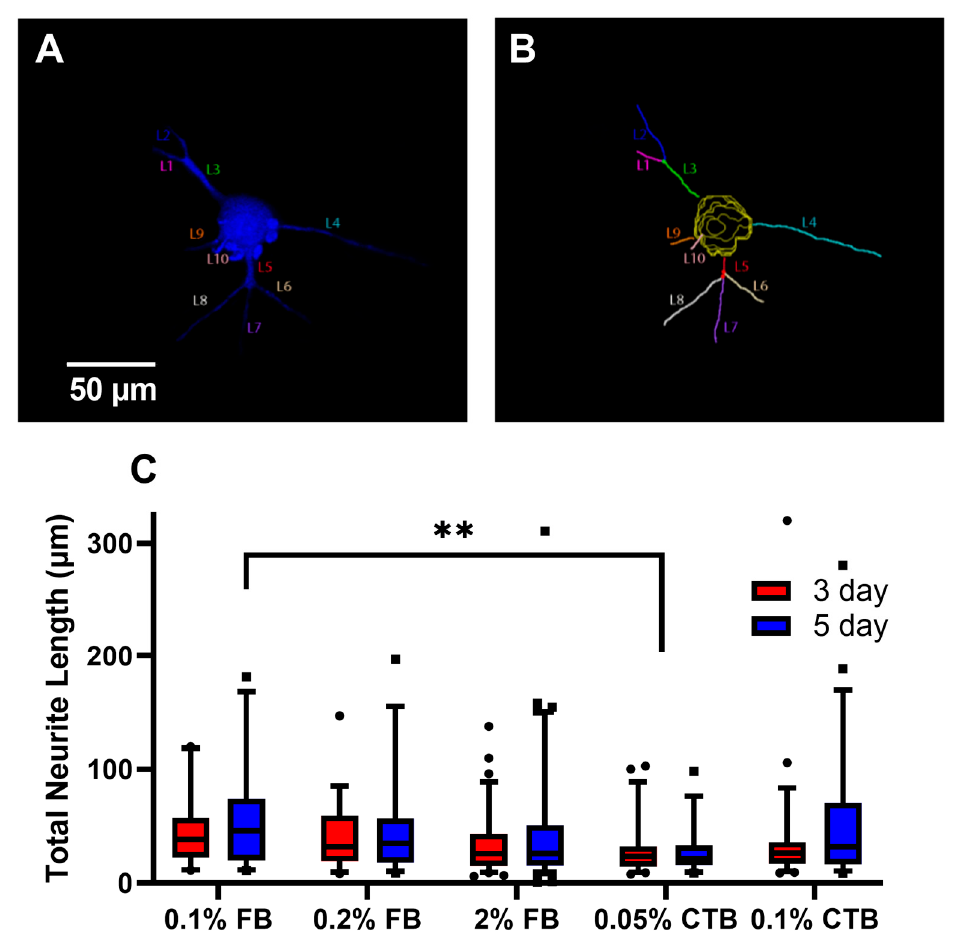
Figure 4. Total neurite length among tracer protocols of young mice (6–7 weeks). ( A ) Image of neurite projection prior to reconstruction from tracer labeling. Image from Neurolucida. ( B ) Image of neurite projections reconstructed from tracer labeling. The total neurite length was calculated as the sum of L1, L2, . . . , L10. ( C ) Total neurite length among tracer protocols. The number of cells analyzed per group (from left to right in order) in ( C ) is 27, 34, 39, 32, 75, 80, 45, 36, 55, and 48. Data are median ± 95% confidence interval. The circles and rectangles are data points outside the 95% confidence interval for the 3-day and 5-day protocols, respectively. ** denotes p < 0.01.